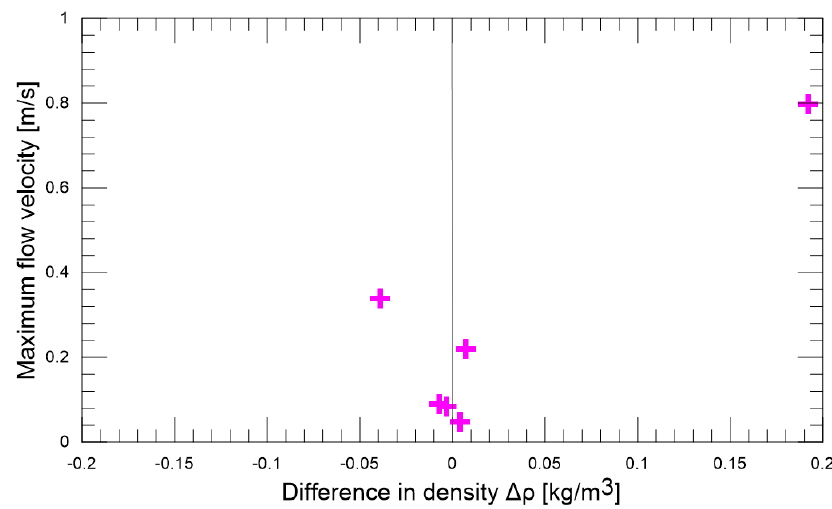
Figure 11. Comparison of the maximum flow velocity measured at leakages in CFD analysis for different values of Δρ .